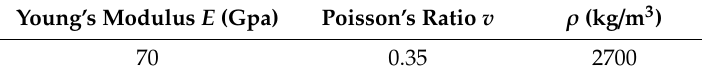
Figure 2. Schematic of experiments. Table 1. Material properties of the aluminum plate.